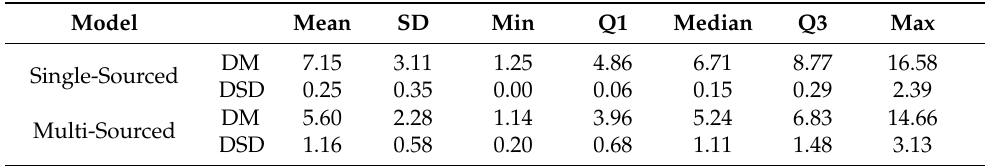
Table 3. The spatial mean and variability of PM 2.5 concentration estimates from a single-sourced and multi-sourced exposure